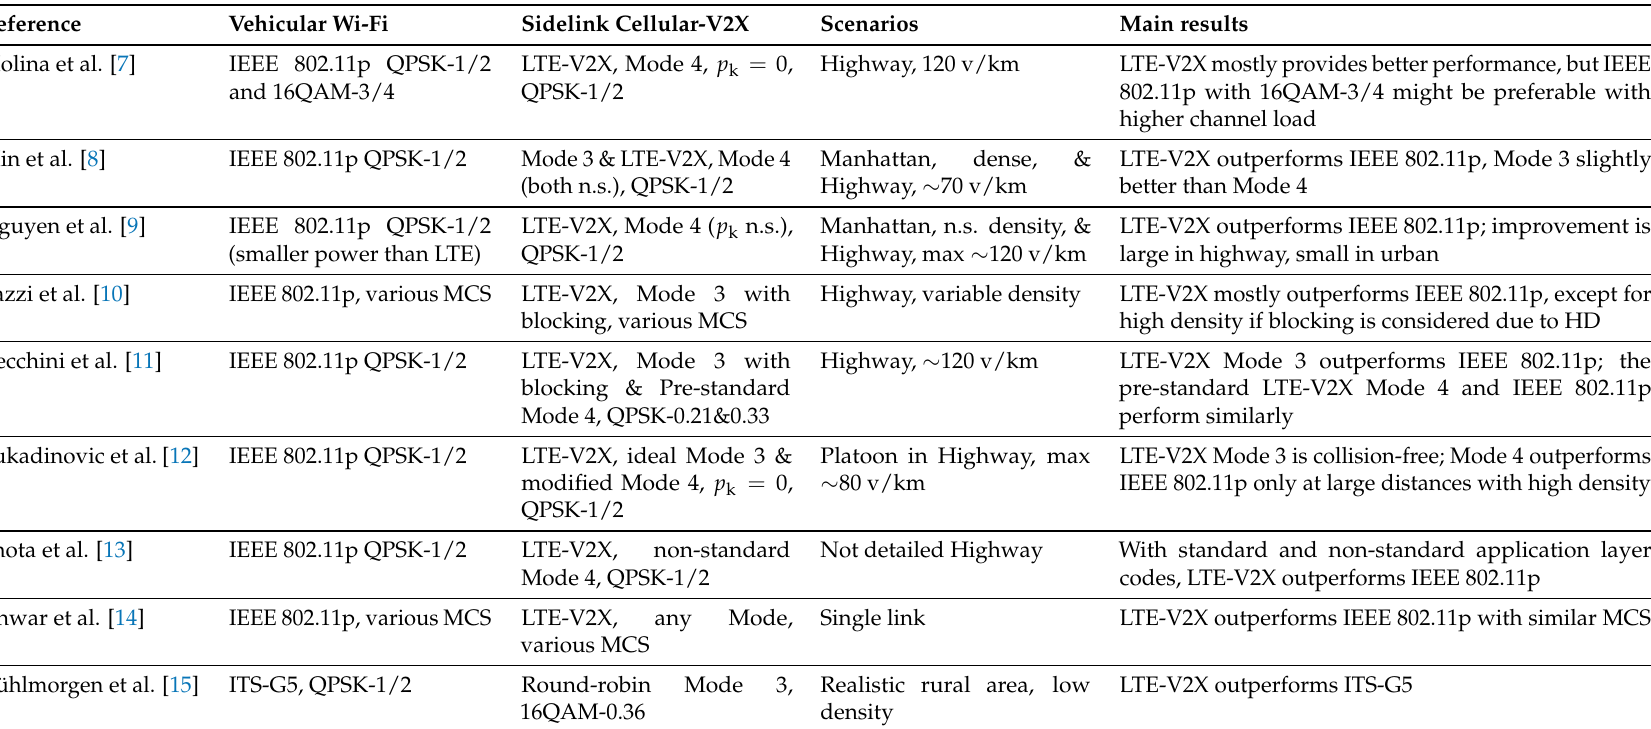
Table 4. Related work dealing with Vehicular Wi-Fi vs. Sidelink Cellular-V2X. n.s. means not specified